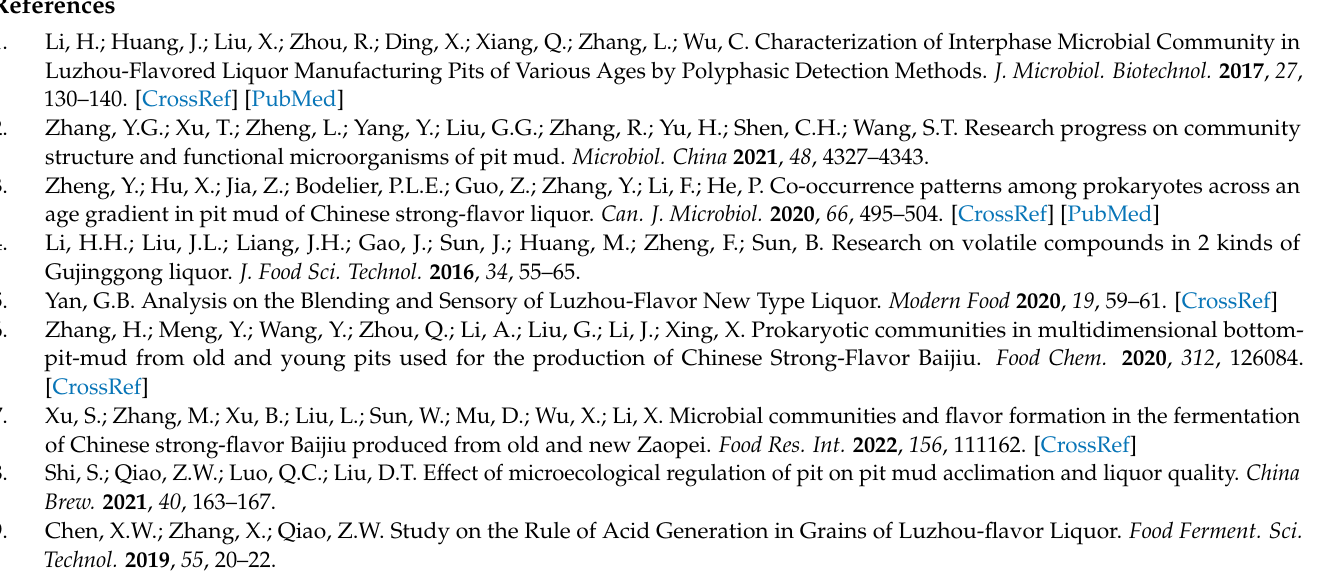
Table S1: Statistical analysis of sequencing data of amplicon library of EFB bacteria 16S rDNA; Table S2: Abundance table and percentage content data table of microbial